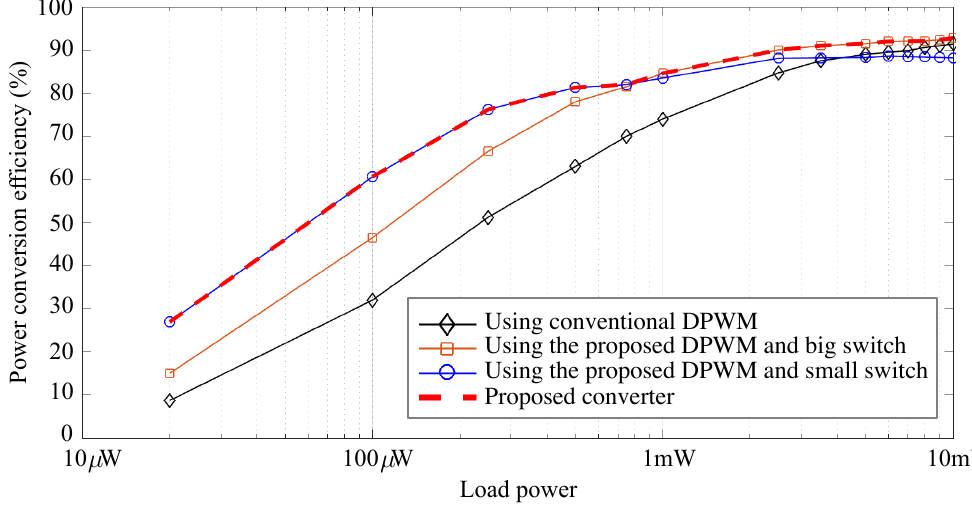
Figure 8. Measured η of the conventional and proposed